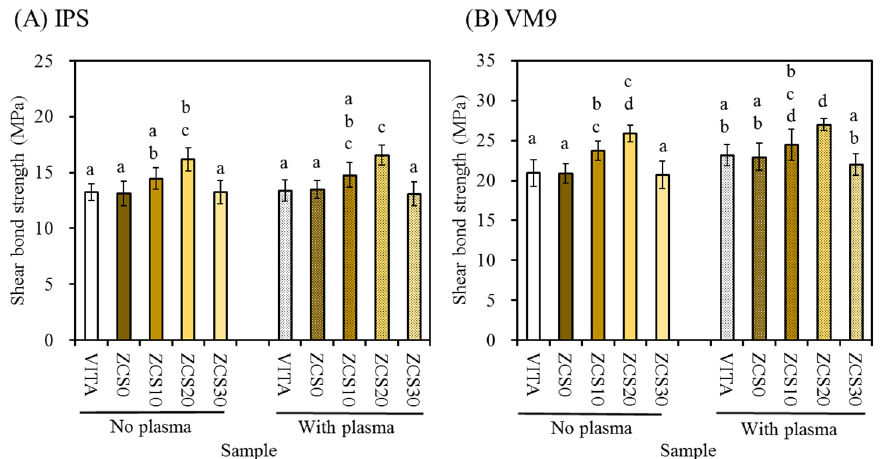
Figure 6. Shear bond strength of ( A ) IPS e.max Ceram and ( B ) VM9 veneering ceramics to various core specimens. Different lowercase letters showed statistically significant differences ( p < 0.05) (n = 10).